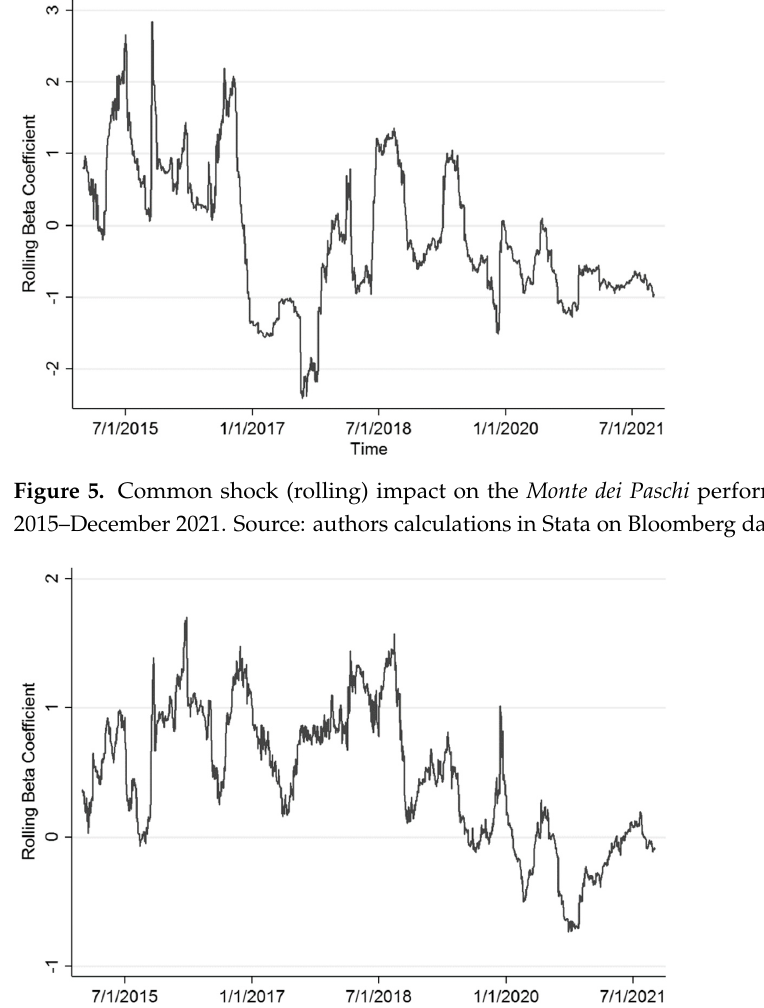
Figure 4. Figure 4. Common shock (rolling) impact on the Unicredit performance: period January 2015–De- cember 2021. Source: authors calculations in Stata on Bloomberg data.